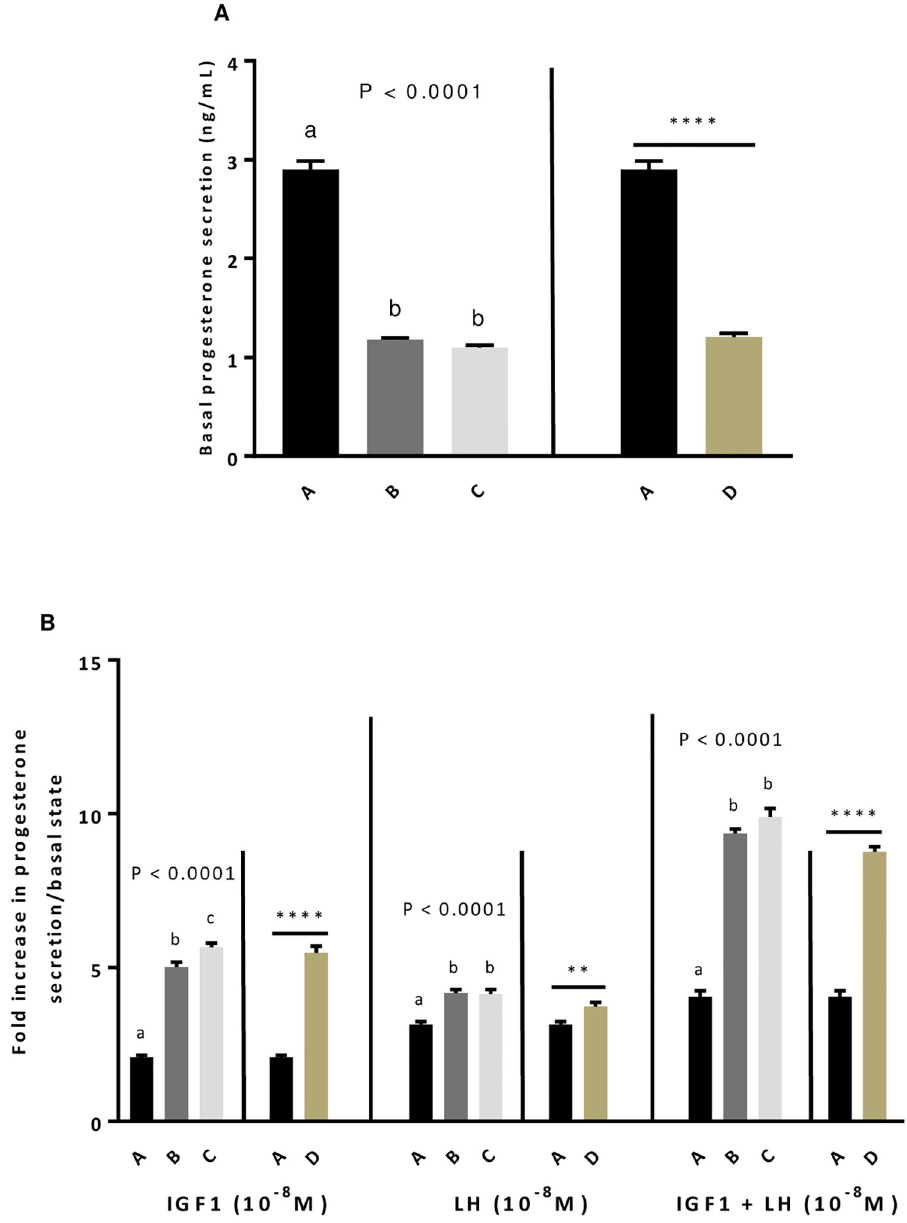
Fig 4. Effect of dietary GSE supplementation on in vitro steroidogenesis at basal state (A) and in response to IGF1 and LH alone or in combination in hen primary granulosa cells. Granulosa cells from preovulatory follicles 1 (F1) from different group of animals (A to D) were seeded for 24 h and after overnight serum starvation, granulosa cells were incubated with IGF1 (10 -8 M), LH (10 -8 M) or both for 48 h. The culture medium was then collected. Basal progesterone level (A) and the response to IGF1 or/and LH (B) were assessed. A: animals fed with control diet without GSE supplementation, B and C: animals supplemented with GSE at 0.5% and 1% of the total diet composition, respectively, starting at 4 week-old until 40 week-old, and D: supplementation with GSE at 1% of the total diet composition starting at hatch until 40 week-old. Results are presented as lsmeans ± S.E.M. P values and different individual letters indicate a significant effect of the diet between A, B and C groups (experiment 1) or between A and D groups (experiment 2). P value was considered as significant if P < 0.05. �� P < 0.005 and ���� P < 0.0001.